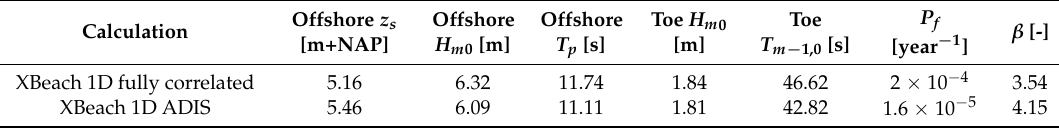
Table 4. Comparison of the probabilities of failure as calculated with ADIS and as calculated with an approach that uses the same probability exceedance value for each of the stochastic parameters (fully correlated). Results for XBeach 1D with the three offshore parameters as stochastic